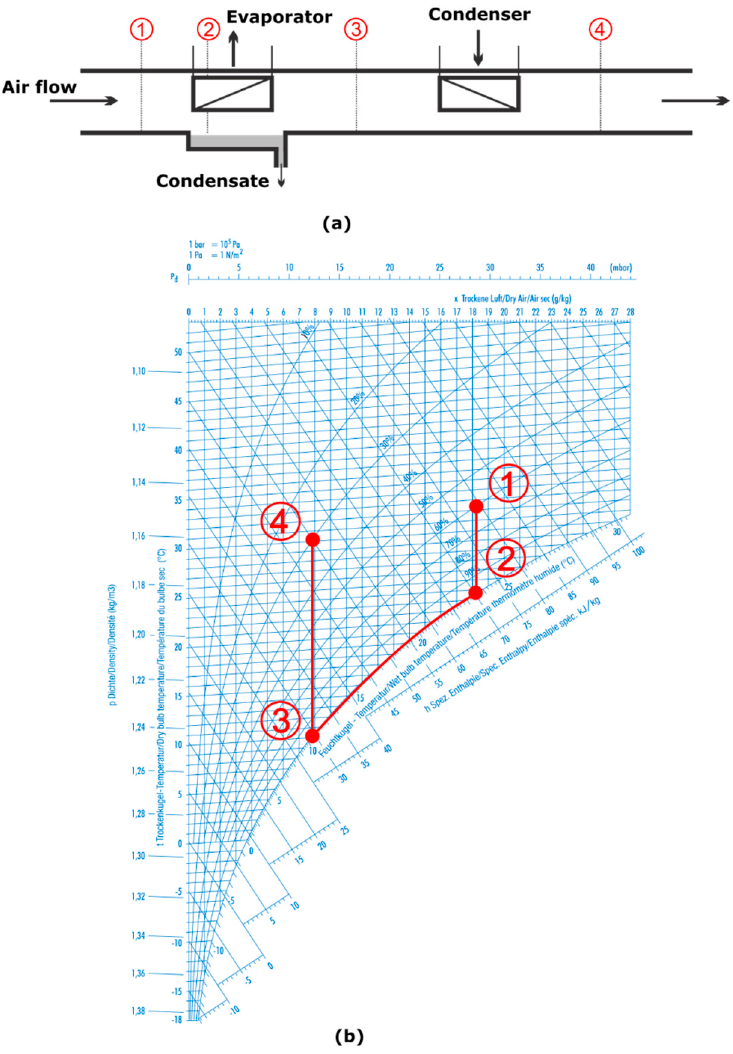
Figure 1. Diagram of the drying process ( a ) and the drying process in the psychometric graph ( b ).